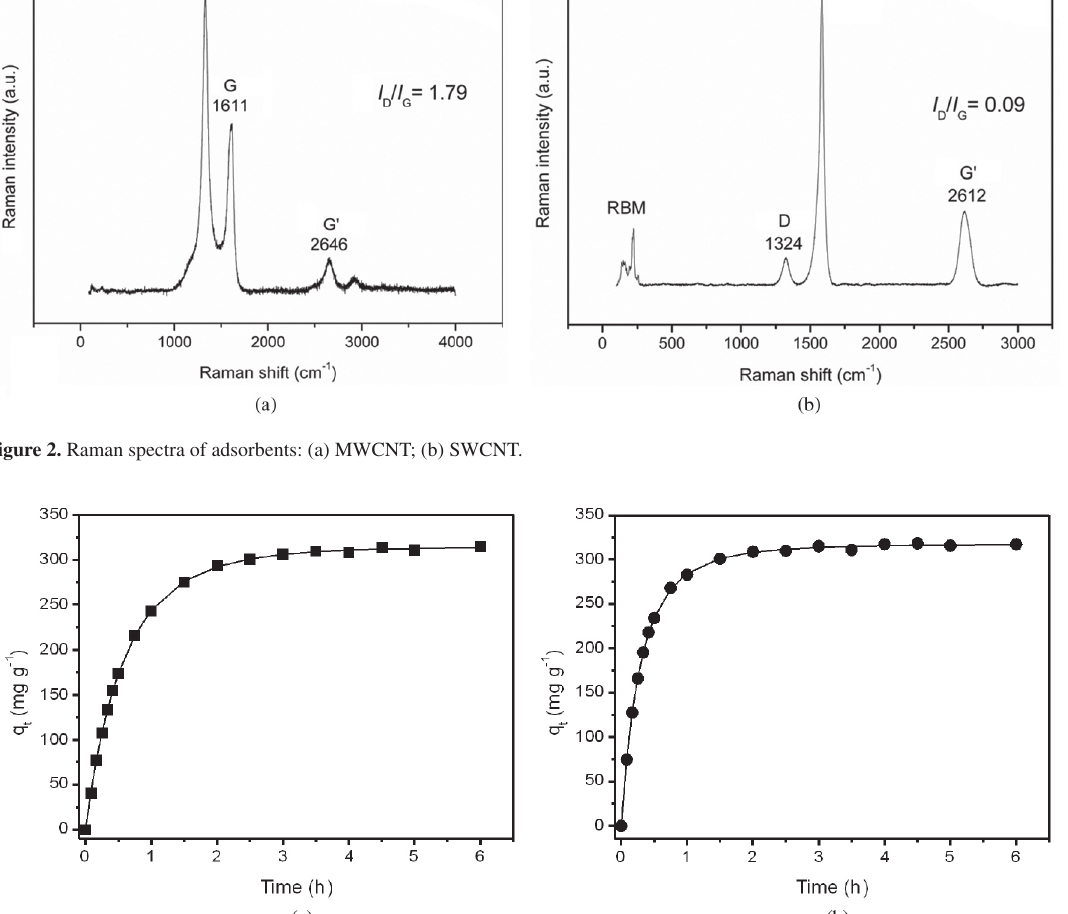
800.0 mg L –1 of dye o